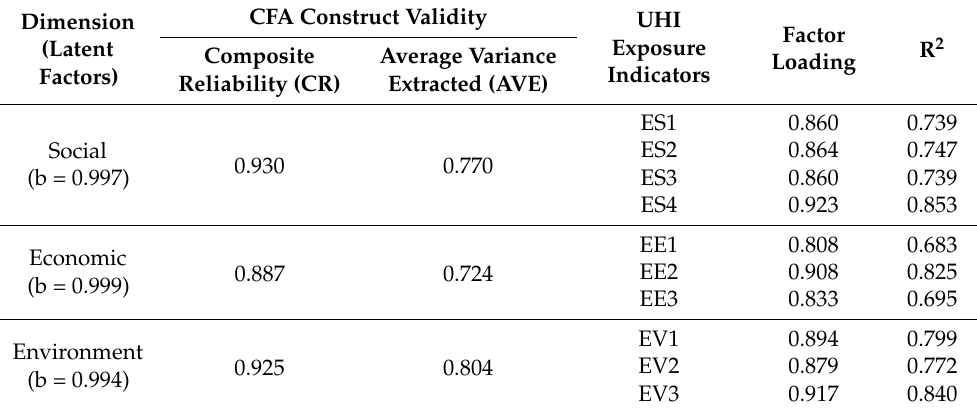
Table 6. First- and second-order CFA of UHI exposure indicators. Dimension (Latent